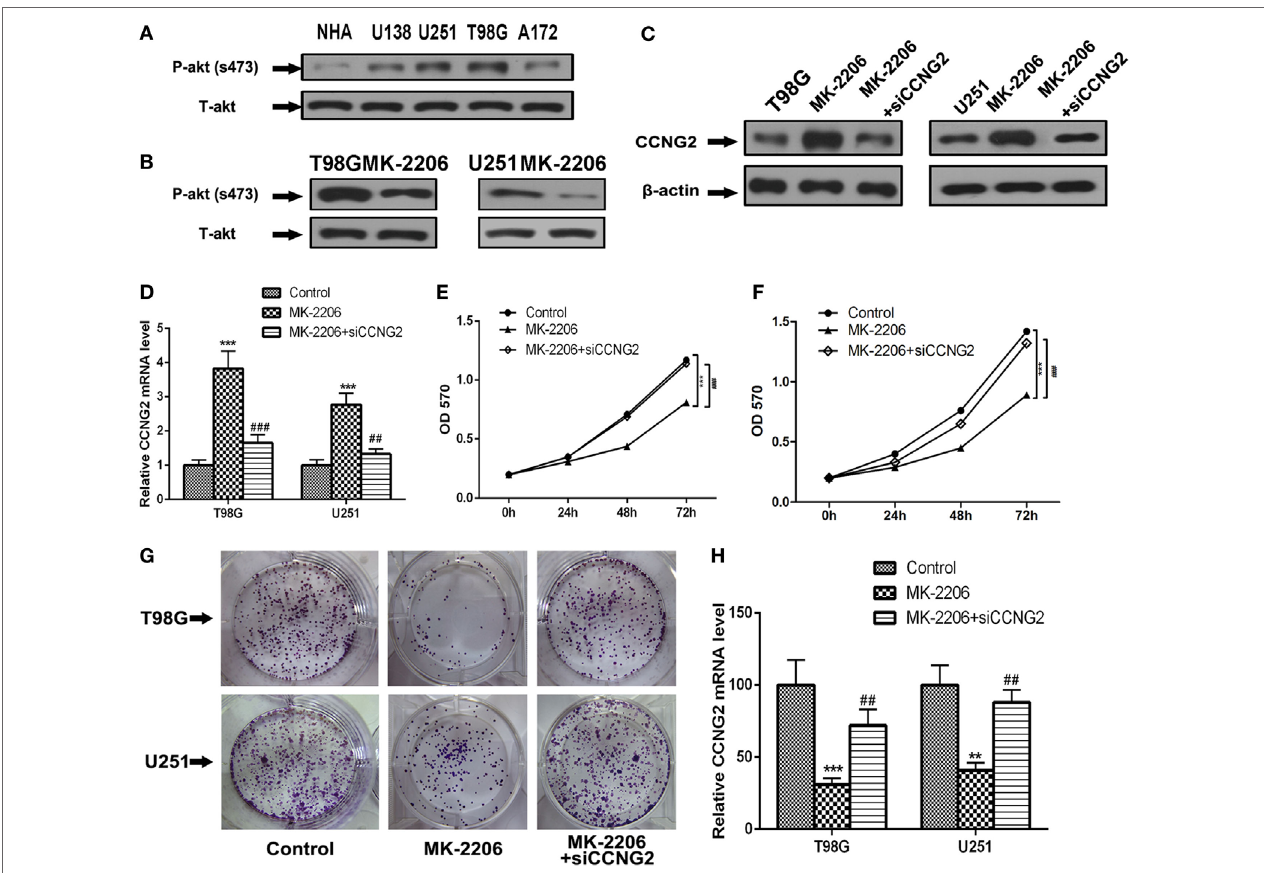
FigUre 5 | Inhibition of AKT inhibits cell proliferation in T98G and U251 cells is mediated by the modulation of CCNG2. (a) Phospho-AKT (S437) and total-AKT protein expression levels in four glioblastoma cell lines and normal astrocytes cell were analyzed by western blotting. (b) Western blotting detected the expression levels of phospho-AKT (S437) and total-AKT in T98G and U251 cells treated with AKT kinase inhibitor MK-2206 or a vehicle control. (c,D) RT-PCR and western blotting detected the expression levels of CCNG2 in T98G and U251 cells treated with MK-2206 or siCCNG2 or a vehicle control. Cell proliferation was detected by MTT assay in (e) T98G and (F) U251 cells treated with MK-2206 or siCCNG2 or a vehicle control. (g,h) Colony formation assays in T98G and U251 cells showed that inhibited AKT resulted in a significant decrease in colony number compared with the vehicle control groups and siCCNG2 restored this suppression. Data were expressed as means ± SEM ( n = 3). ** P < 0.01, *** P < 0.001, ## P < 0.01, ### P < 0.001 by the unpaired two-tailed Student’s t